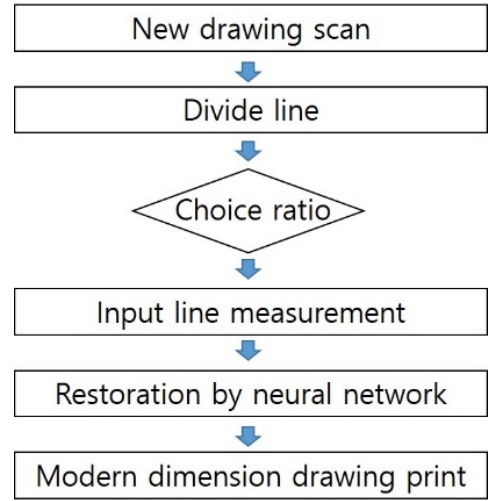
Figure 3. Flowchart. Figure 3.